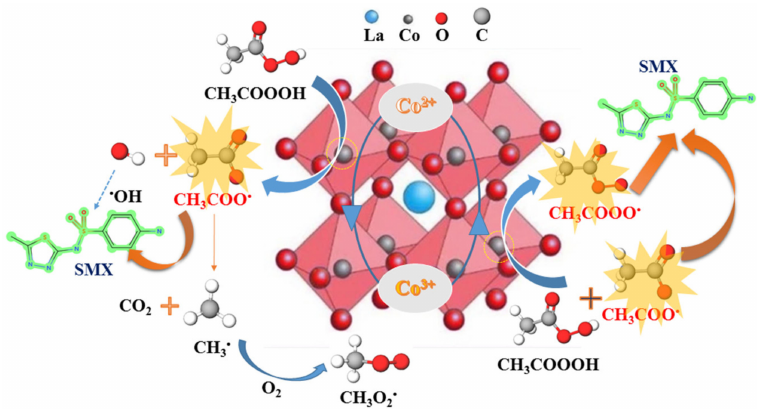
Figure 5. Proposed mechanism of PAA activated by LaCoO 3